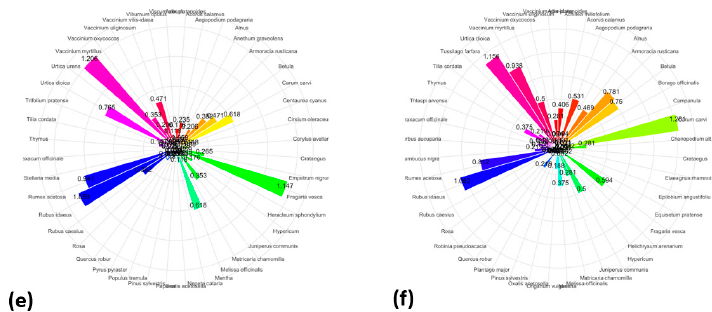
Figure A1. Radial plots of cultural importance (CI) index values for the case studies: ( a ) BYLT, ( b ) BYPL, ( c ) LTLT, ( d ) LTPL, ( e ) PLLT, and ( f ) PLPL. Analysis performed using EthnobotanyR package in RStudio